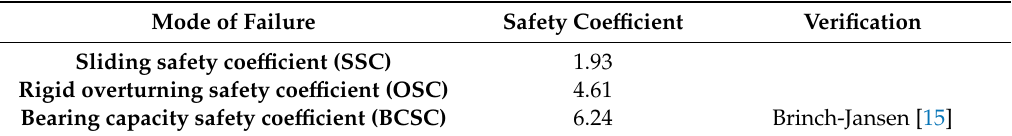
Table 1. Safety coe ffi cients obtained for load state A. Table 1. Safety coefficients obtained for load state A. Table 1. Safety coefficients obtained for load state A.